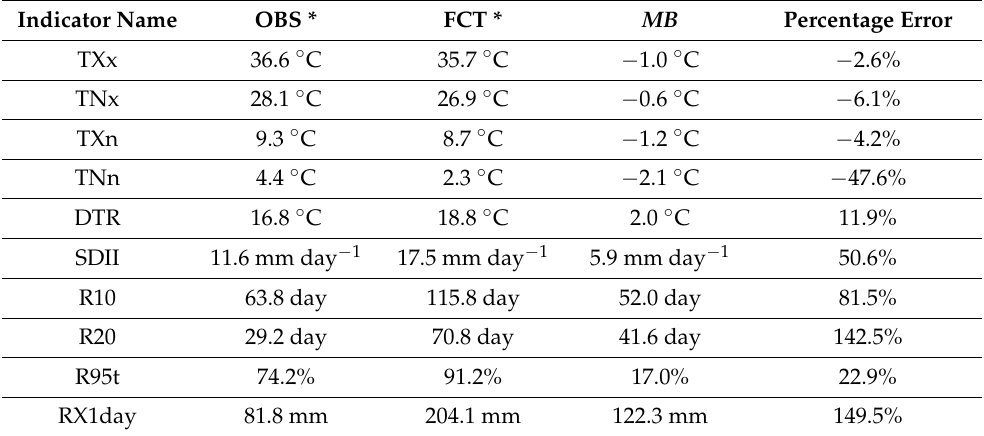
Table 5. The comparison of extreme weather indices for simulation and observation data collected during 2013–2017 over Pearl River